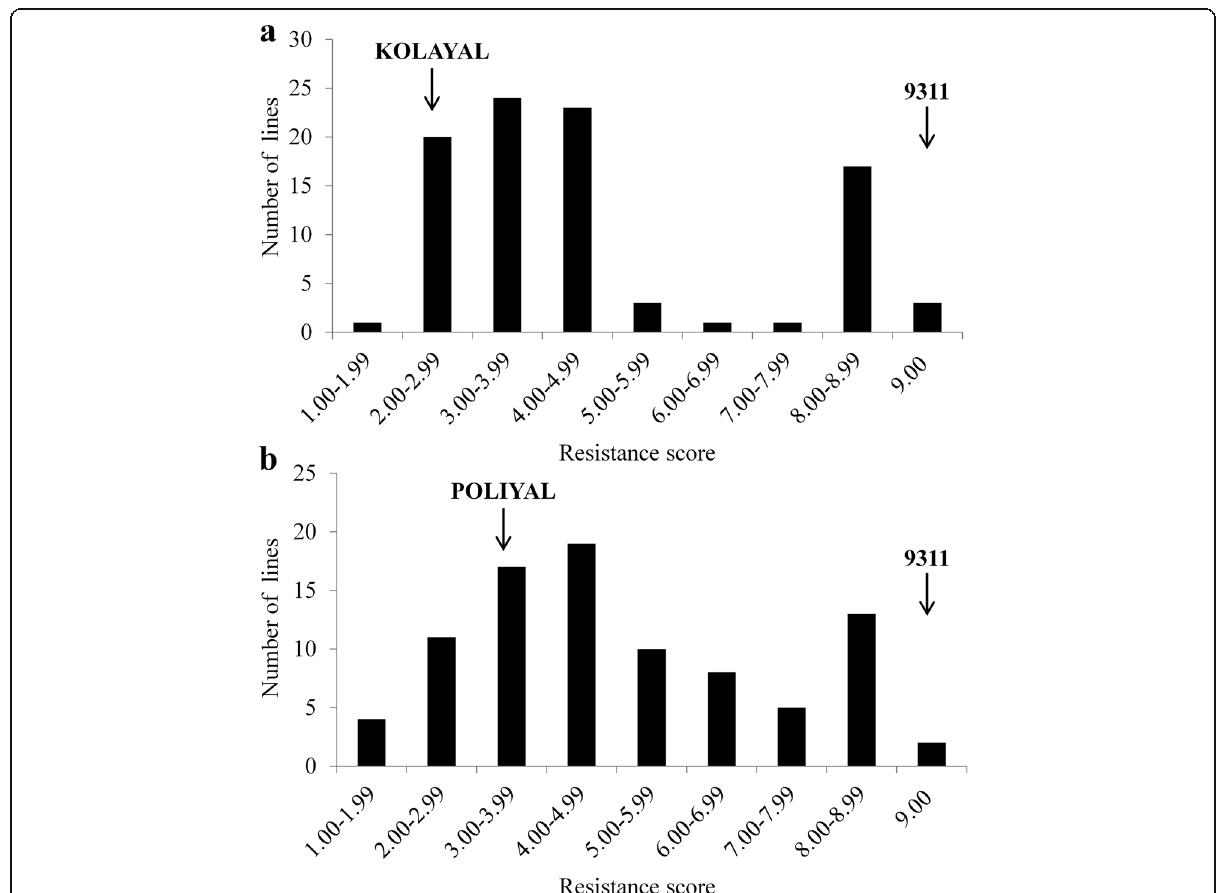
Fig. 1 Frequency distribution of BPH resistance score in two F 2:3 populations. a Population from 9311 × KOLAYAL; b Population from 9311 × POLIYAL. The resistance scores of individuals were measured at the time of 12 days after infestation